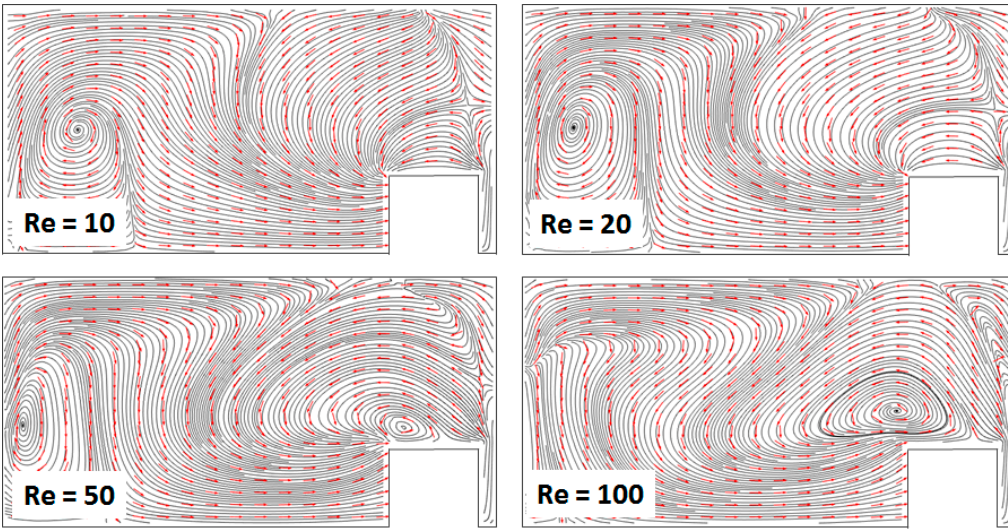
Figure 8. Cross-sectional streamline/arrow plots of the velocity field for the mixer with R in = 400 μ m, at different Reynolds numbers. The data is collected midway through the second mixing subsection.